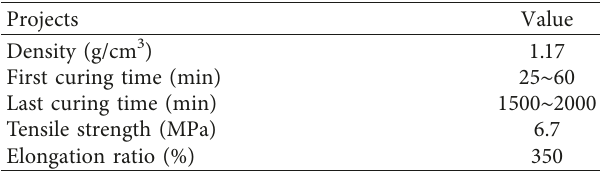
Table 1: Basic properties of the PU binder.